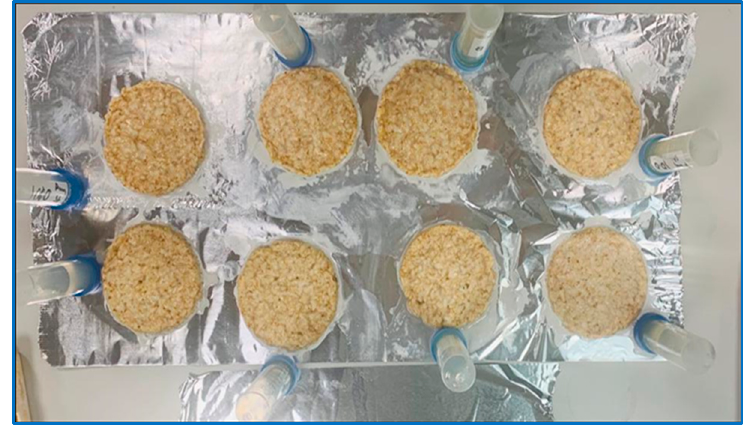
Figure 3. Rice cakes dipped in sodium hydroxide solution.